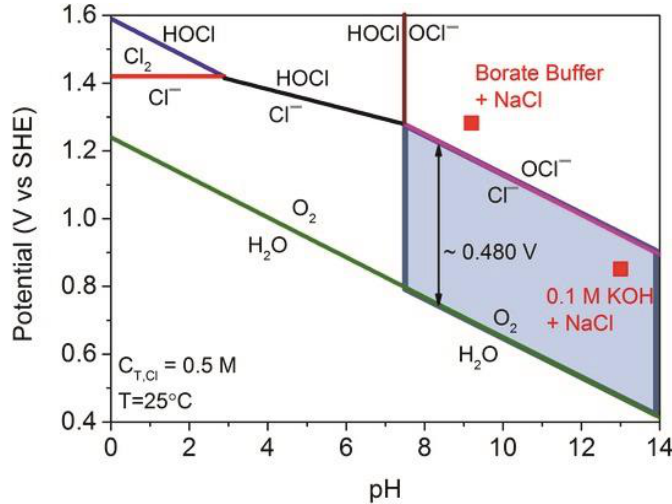
Figure 1. Pourbaix diagram for artificial seawater model [27]. Adapted with permission Ref. [27], Copyright 2016, Wiley-VCH.